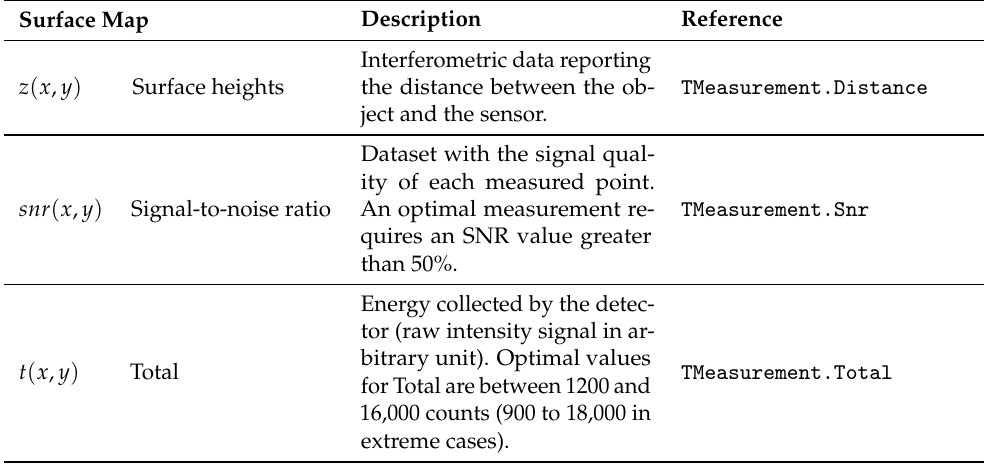
Table 1. Description of the dataset collected by the microprofilometer [27]. Type definitions from Conoprobe OEM API Reference is also given